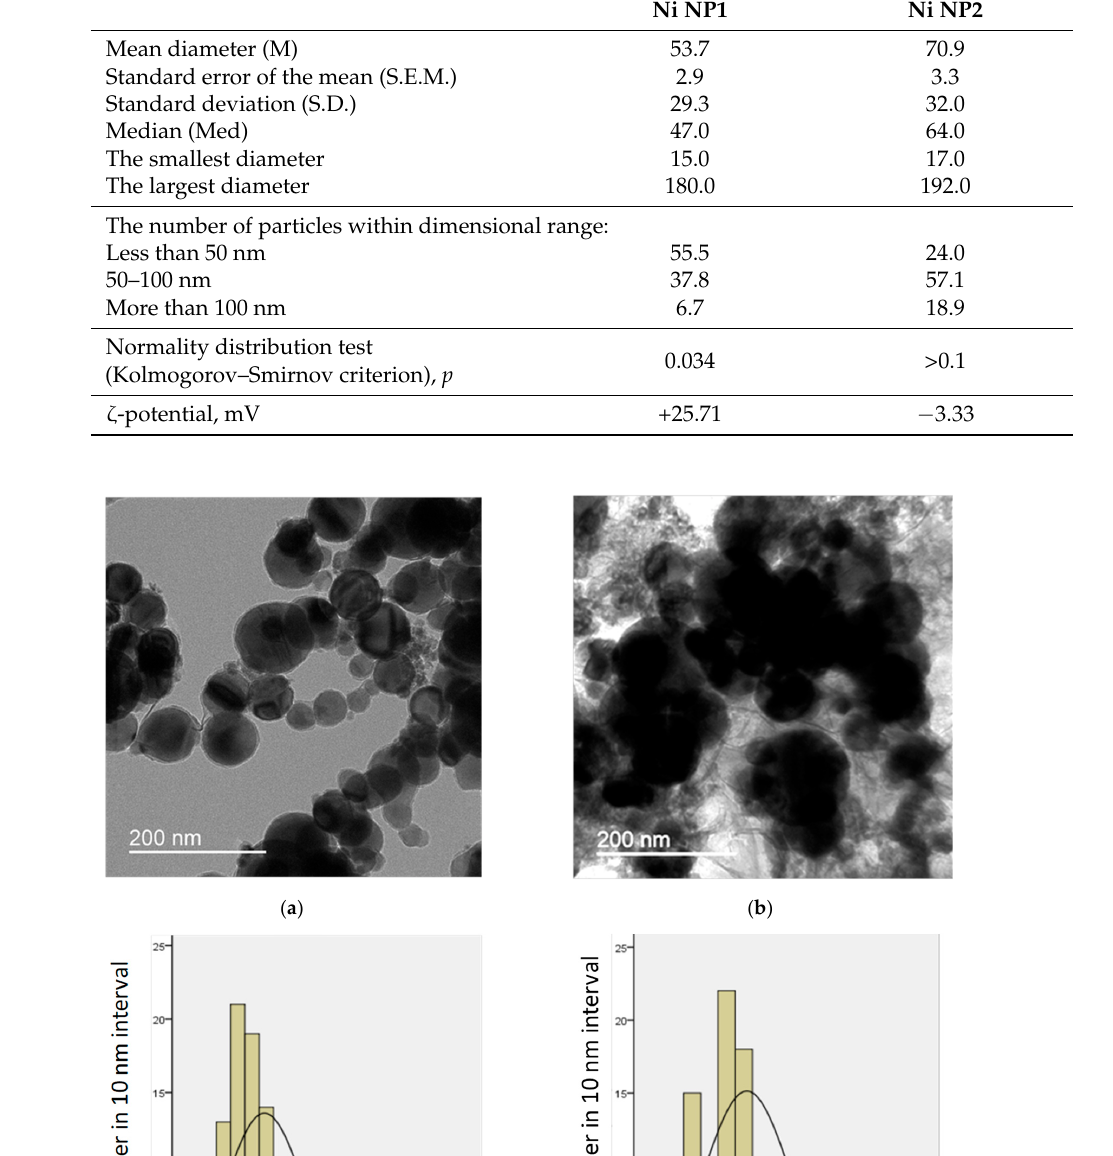
Table 1. Dimensional characteristics of Ni NP1 and Ni NP2 according to TEM data.